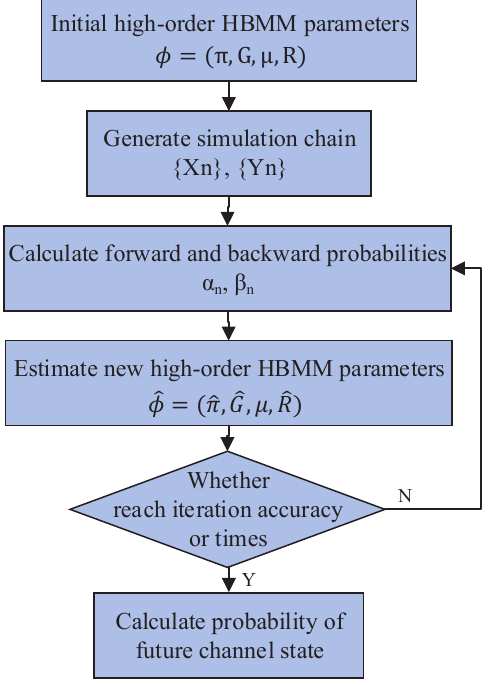
Figure 4. High-Order HBMM (H 2 BMM) training